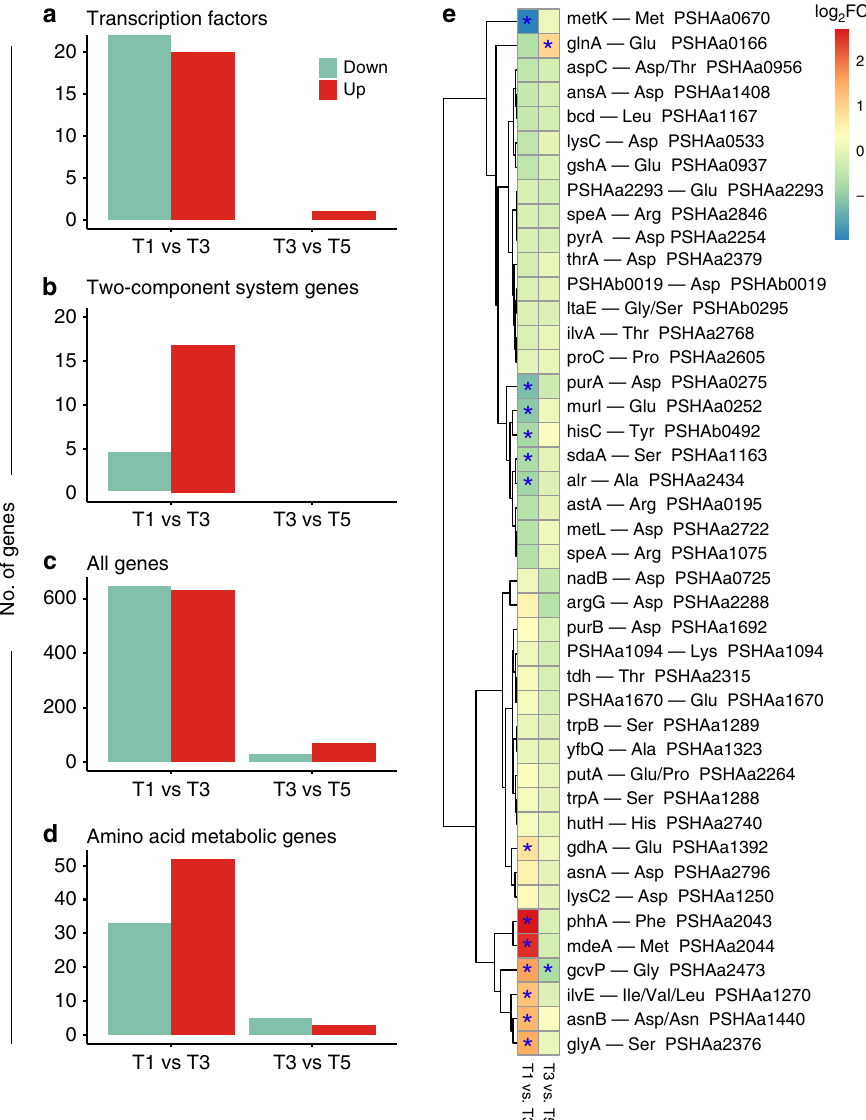
Fig. 2 Differentially expressed genes. a – d Number of up- and downregulated genes in the two contrasts considered, for different gene categories. e Fold change of each gene responsible for the fi rst degradative step of each amino acid. Differentially expressed genes are marked with an asterisk. Source data are provided as a Source Data fi